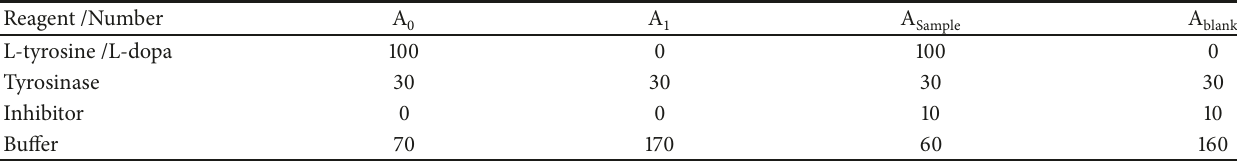
Table 4: Loading table.